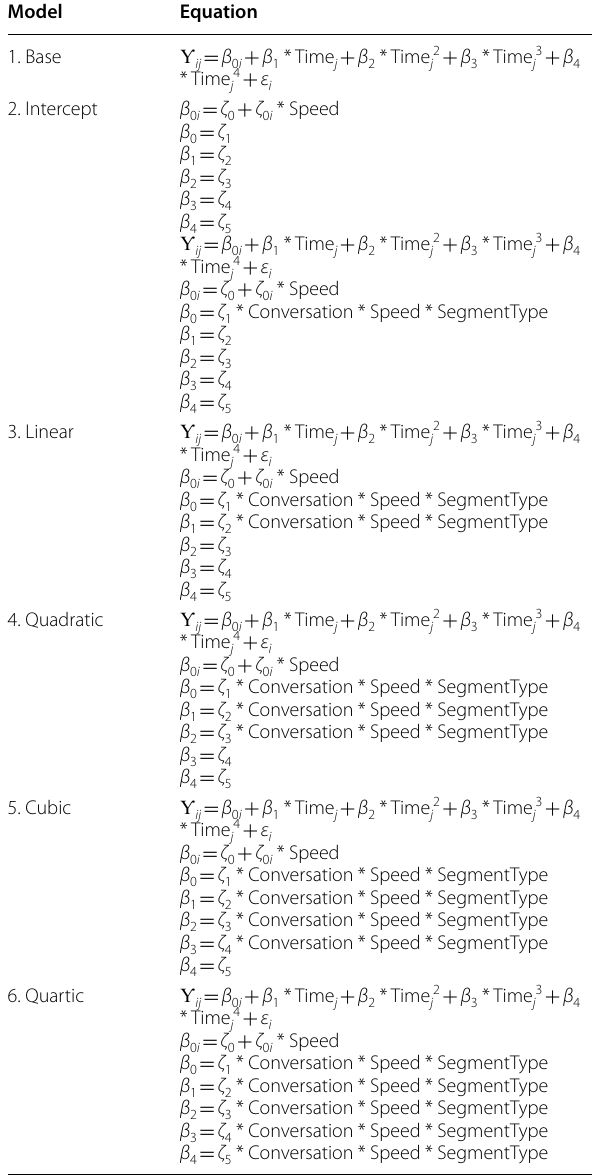
Table 1 Growth curve models for fitting distance from target for subject i at time point j Model